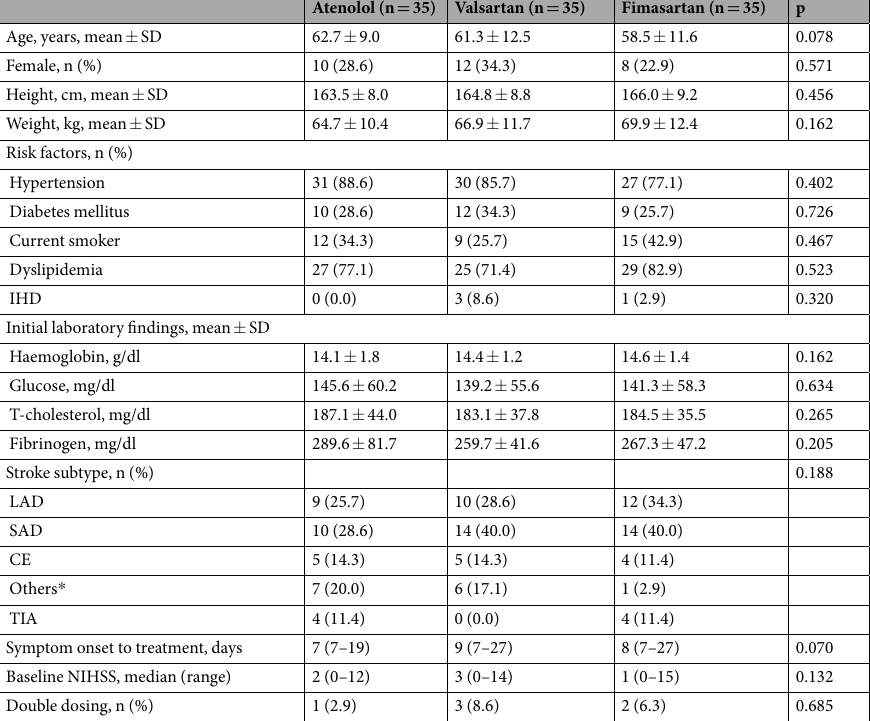
Table 1. Baseline demographics of atenolol, valsartan, fimasartan groups. CE indicates cardioembolism; IHD, ischemic heart disease; LAD, large artery disease; NIHSS, NIH stroke scale; SAD, small artery disease; SD, standard deviation; TIA, transient ischaemic attack, * others were comprised of cryptogenic embolism and arterial